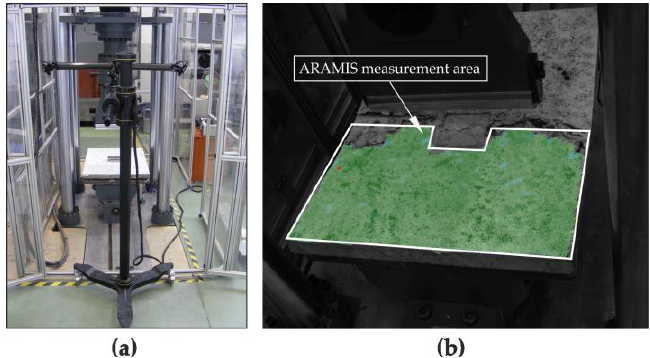
Figure 3. ( a ) Non-contact 3-D deformation measurement system; ( b ) Measurement area of top surface of slab.